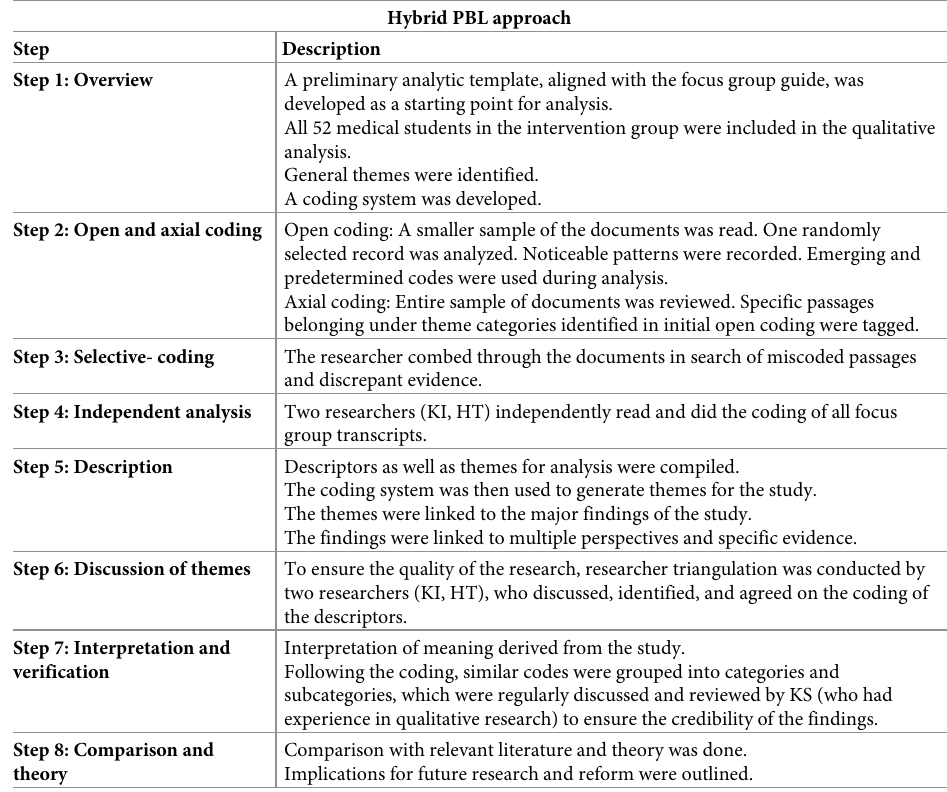
Table 1. The step of qualitative content